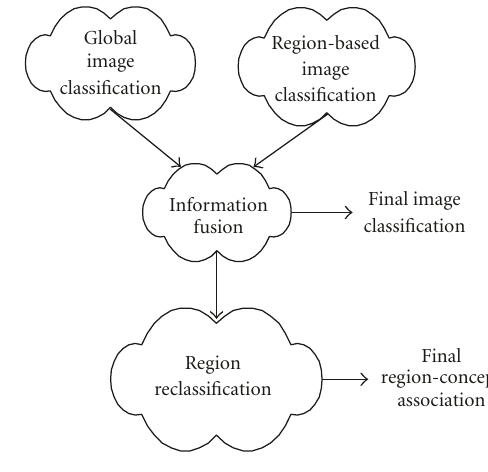
Figure 1: General system